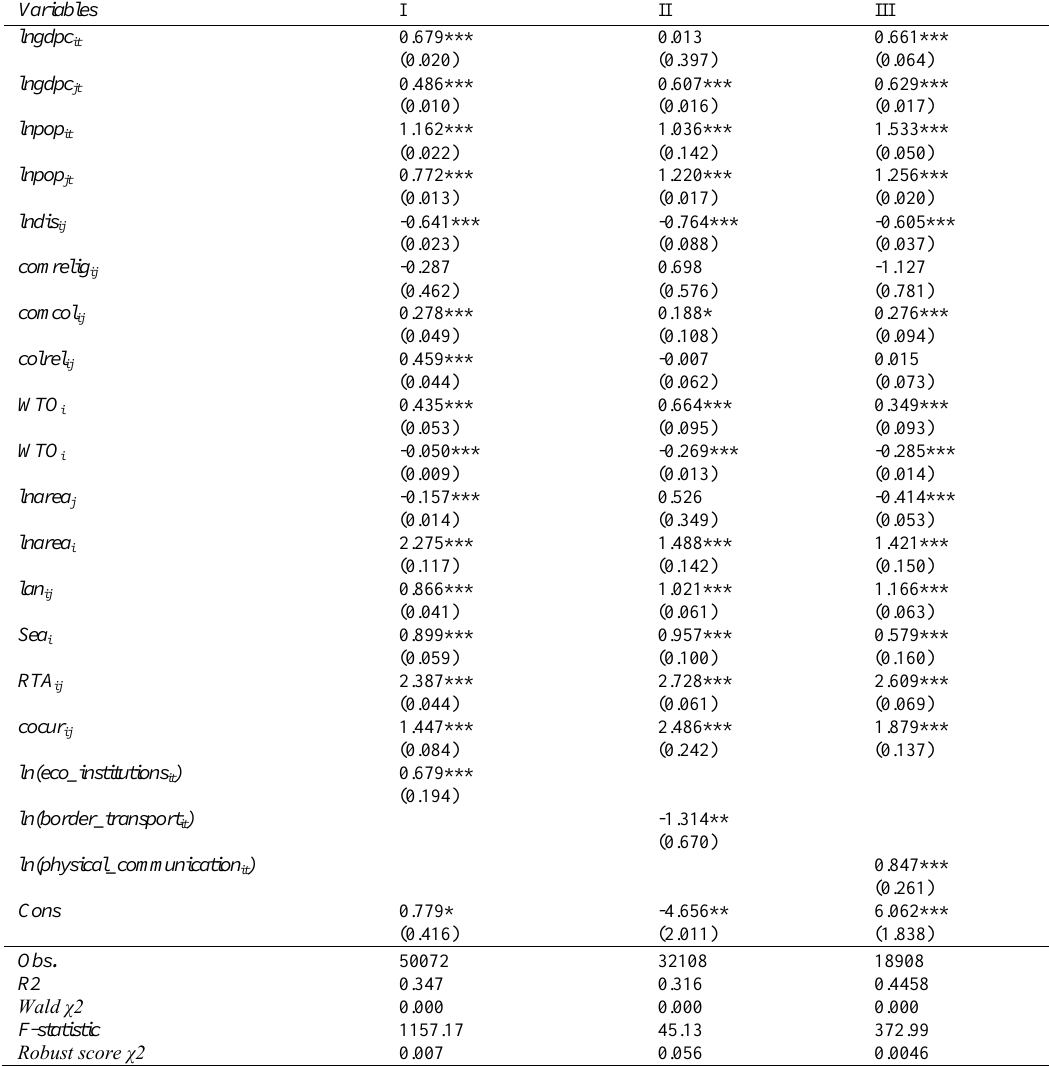
Table 3 : The effects of quality of economic institutions, border and transport efficiency, and physical and communication infrastructure on overall trade flow (IV regression